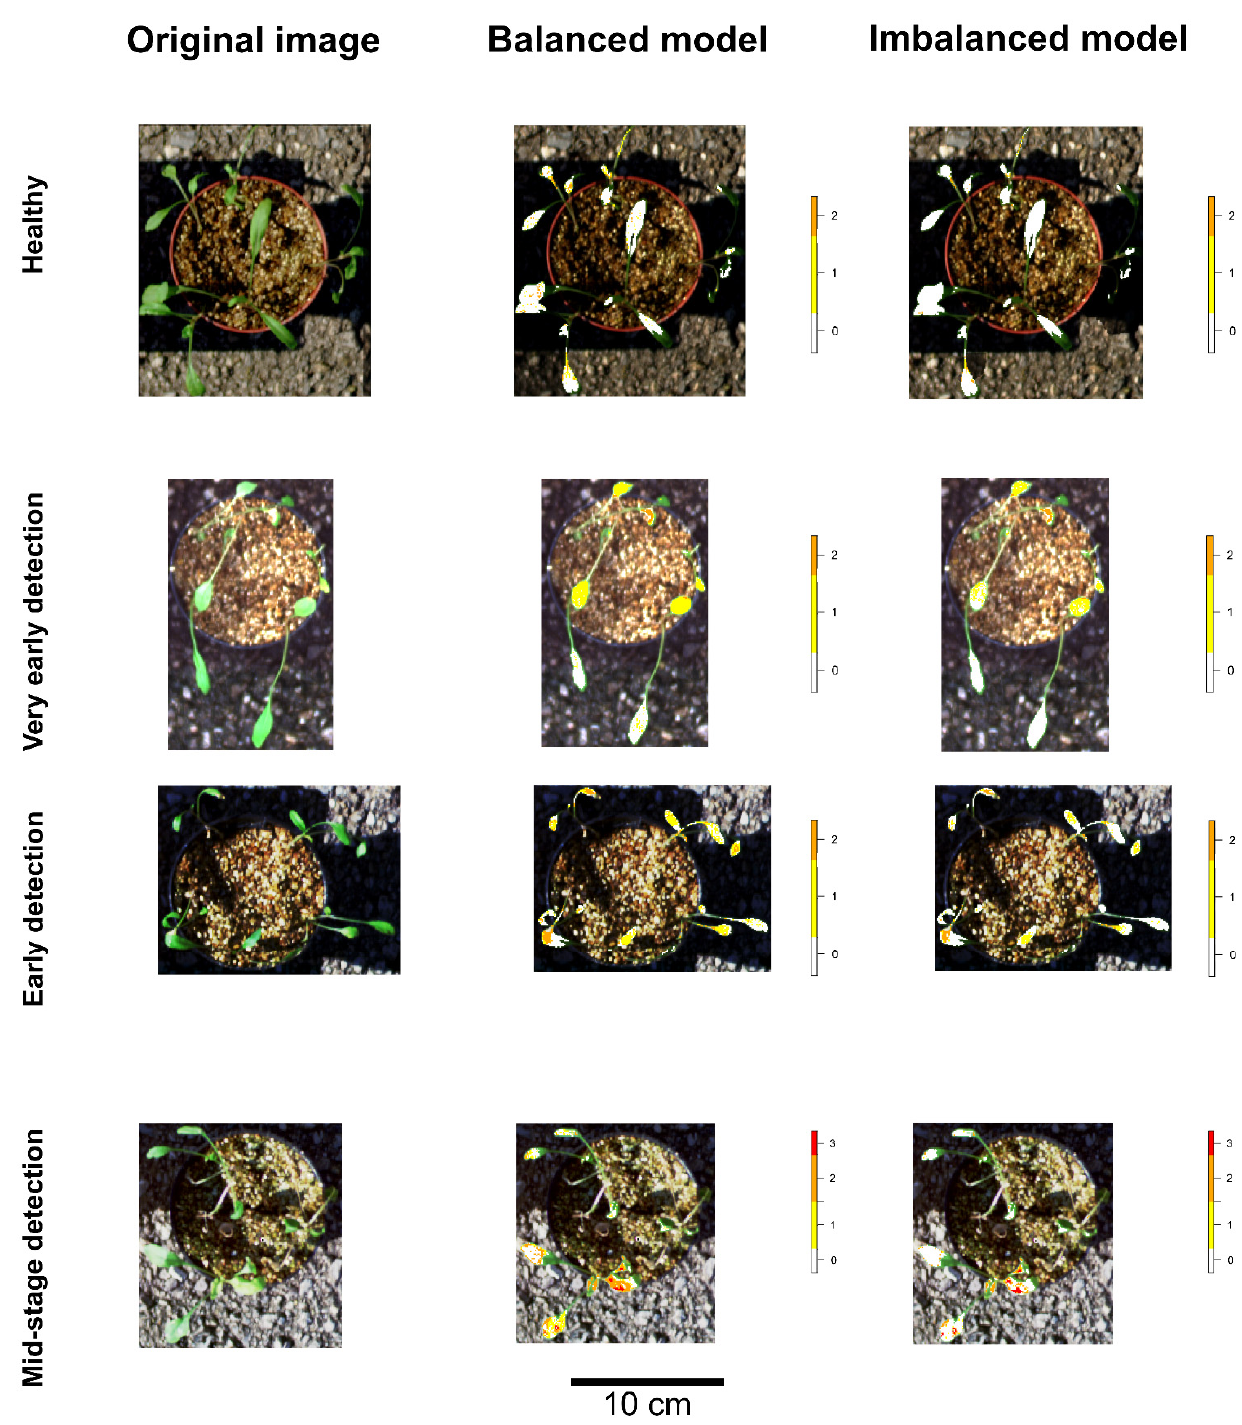
Figure 11. Graphical results of full model predictions on independent datasets. The rows of the plots in the figure represent, from the top, the pots of healthy and infected plants at 5 (very early detection), 10 (early detection), and 15 (mid-stage detection) dpi. The columns of the images represent, from the left side, the original image of each pot, the prediction by the model correcting for class imbalance and the prediction produced by the models not correcting for class imbalance. The legend to the right of each prediction indicates the color of each disease stage: White for pixels classified as healthy, yellow for pixels classified as DSC 1, and orange and red indicating as DSC 2 and 3 levels,